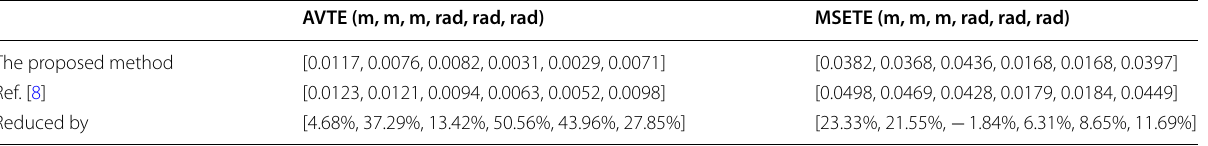
Table 4 Simulation data in 0.5 m/s ocean current environment AVTE (m, m, m, rad, rad,